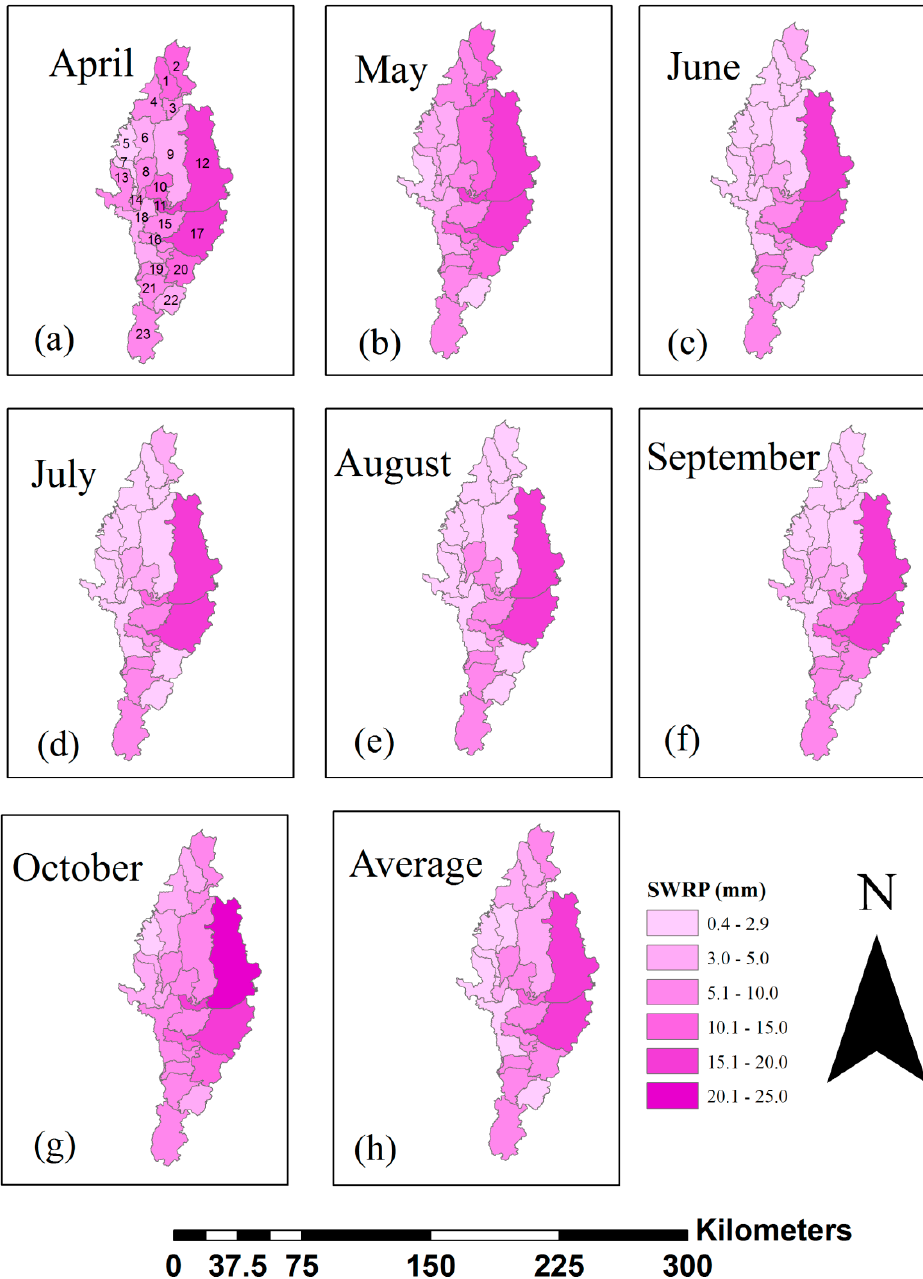
Figure 3. Spatial distribution of simulated weekly stream water resources potential (SWRP) in each sub-basin during crop growing season between 2000 and 2016. * SWRP is defined as: SWRP = SWR − (SE + ST); SWR is stream water resources (SWR); SE is stream water evaporation; and ST is stream transmission.